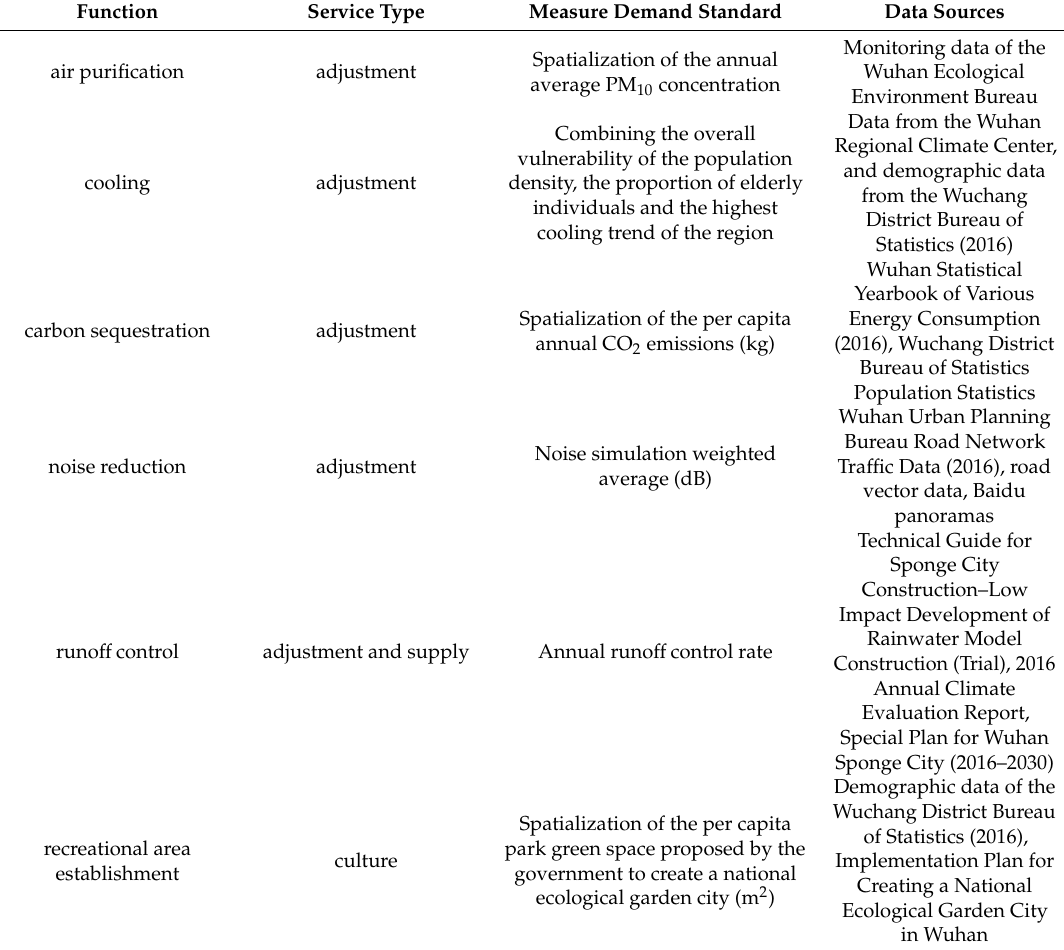
Table 1. Indicator description and data